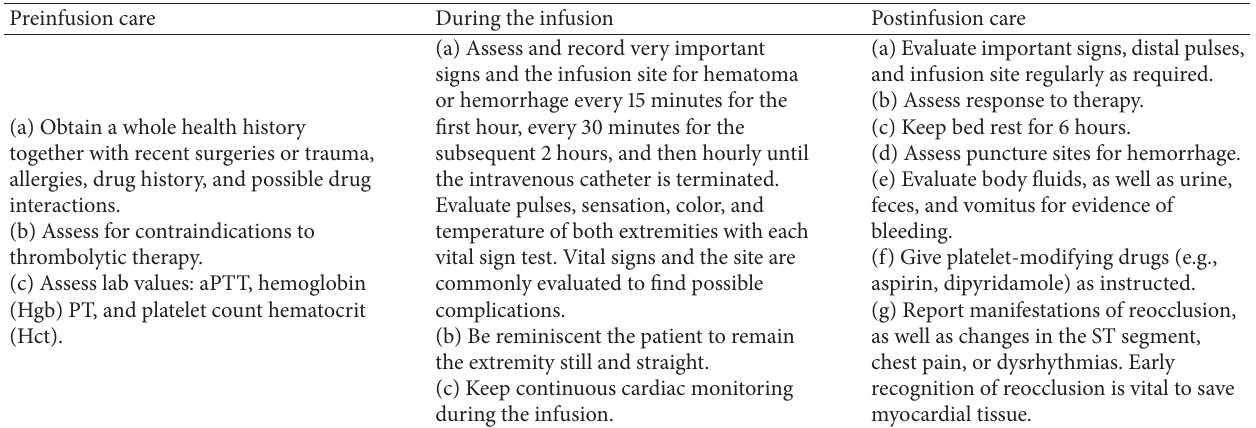
Preinfusion care During the infusion Postinfusion